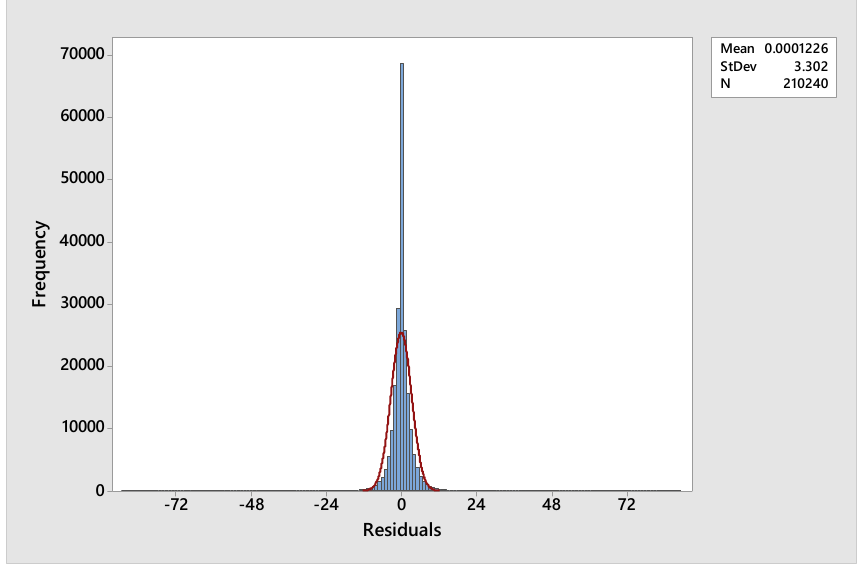
Figure 4. Histogram of wind farm output noise with normal curve